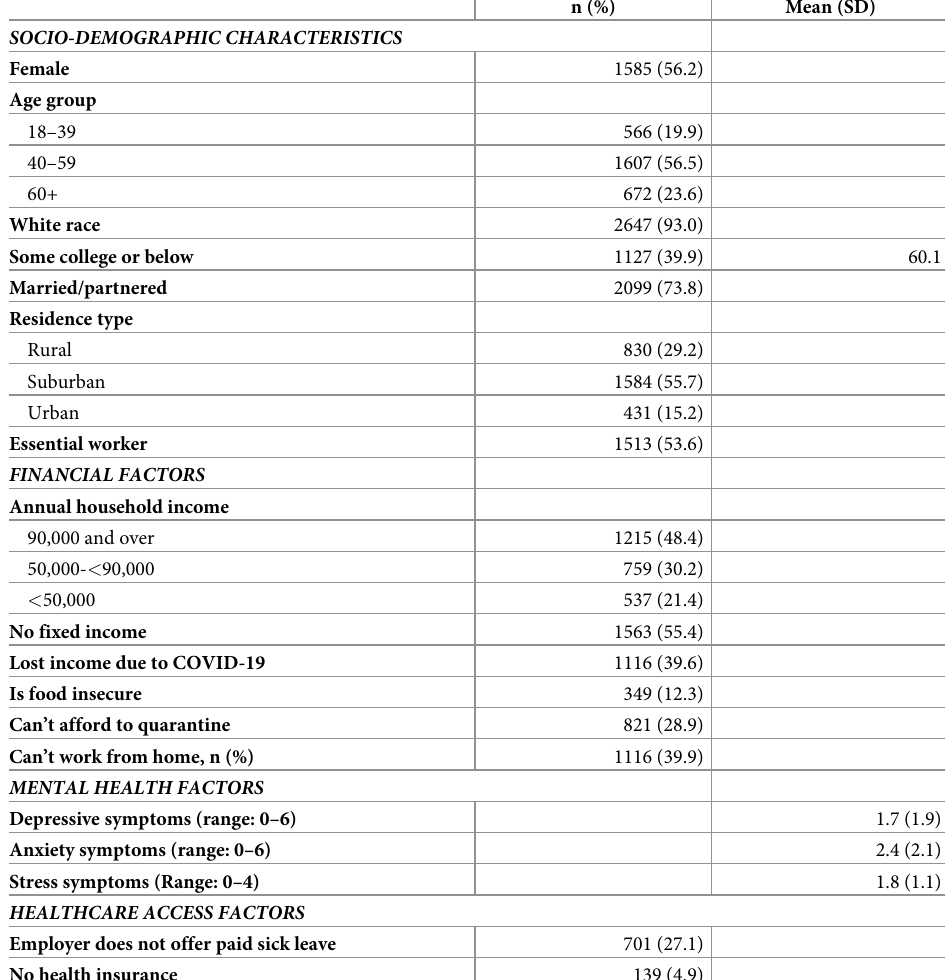
Table 1. Descriptive characteristics of working adults during the COVID-19 pandemic in the US, N = 2,845, April